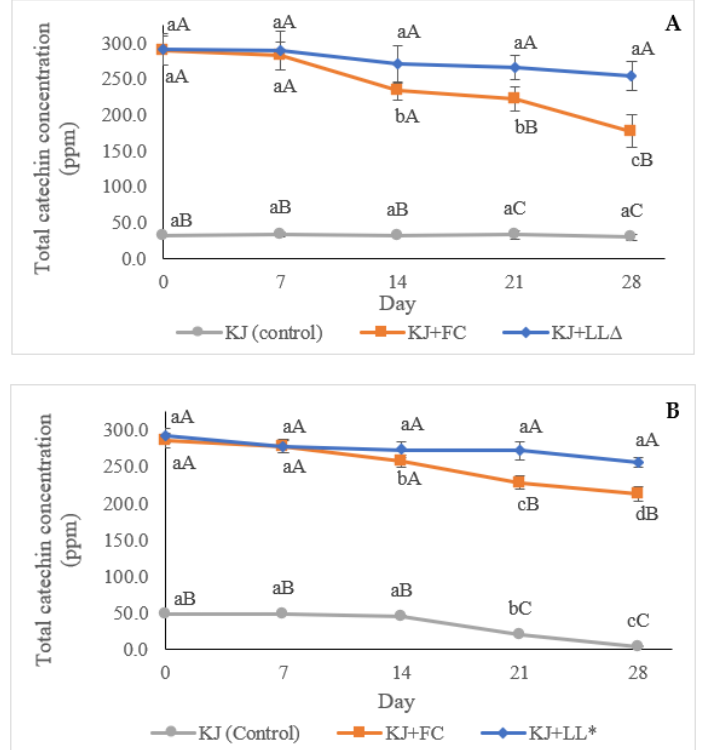
Figure 3. Total catechin concentration (ppm) of the control kiwifruit juice vs. unpasteurised ( A , B ) and pasteurised kiwifruit juice samples, analysed by high-performance liquid chromatography (HPLC). KJ: control kiwifruit juice; KJ + FC: kiwifruit juice containing free green tea waste catechins (GTWCs); KJ + LL ∆ : unpasteurised kiwifruit juice enriched with green tea waste extract (GTWE)-loaded single layer liposomes (SLLs); KJ + LL*: pasteurised kiwifruit juice containing GTWE-loaded SLLs. Different lowercase letters indicate significant ( p < 0.05) differences among the same kiwifruit juice samples for different storage times. Different capital letters stand for statistically significant ( p < 0.05) differences among different kiwifruit juice samples on the same storage day. In terms of the kiwifruit juice containing free GTWCs, a steady decrease was ob- served from Day 0 to Day 28 in the case of both the pasteurised and unpasteurised sam- ples, except for the unpasteurised kiwifruit juice on Day 28, which presented a drastic decrease for free GTWCs. These results indicate that the liposomal encapsulation could protect GTWCs during the pasteurisation process of the kiwifruit juice and until 28 days of storage, while the kiwifruit juice samples enriched with free GTWCs showed a contin- uously decreasing trend over time. Even though the natural GTWCs in kiwifruit juice treated with pasteurisation were mostly degraded after 14 days of storage, the unpasteur- ised sample could remain the same quantity until the end of the storage period. Regarding the discrepancy of the values for the total catechins between the pasteur- ised and unpasteurised control kiwifruit juice samples during storage observed in this study, Tembo et al. [28], who investigated the influence of thermal processing (72 °C, 15 s) on epicatechins in the pasteurised baobab juice stored at 6 °C for 60 days, reported that the pasteurisation could enhance the concentration of epicatechins in the juice about 10% and 70% on Days 0 and 28 of storage, respectively, compared with the unpasteurised juice kept under the same condition. In the case of the current study, after Day 28, the level of epicatechins gradually decreased until Day 60. The reasons for this phenomenon